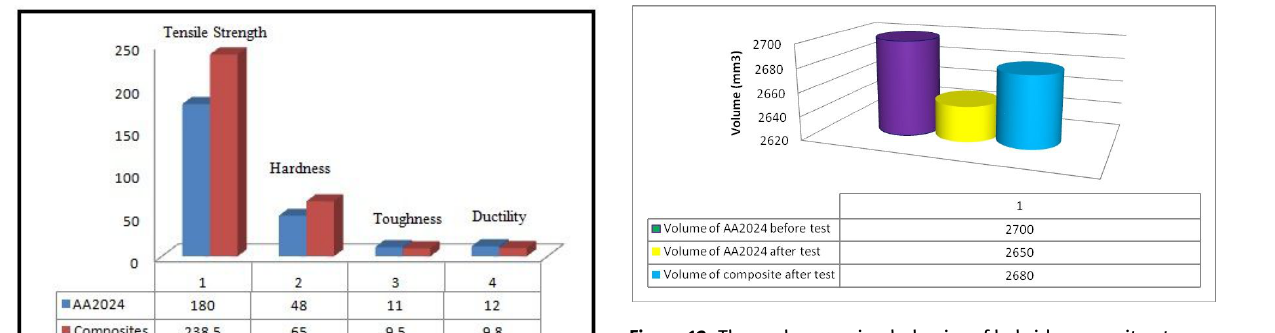
haviour of a hybrid composite at developed at optimum re- inforcement parameters (RHA weight percentage of about 7.8%, RHA preheat temperature of about 231.12 ∘ C, B 4 C pre- heat temperature of about 435.24 ∘ C and B 4 C wt.% of about 6.67%) was investigated. Weight loss of hybrid composite after the corrosion test was found to be 8.98 mg. There was only 0.02 mg material of hybrid composite was corroded as shown in Figure 11.